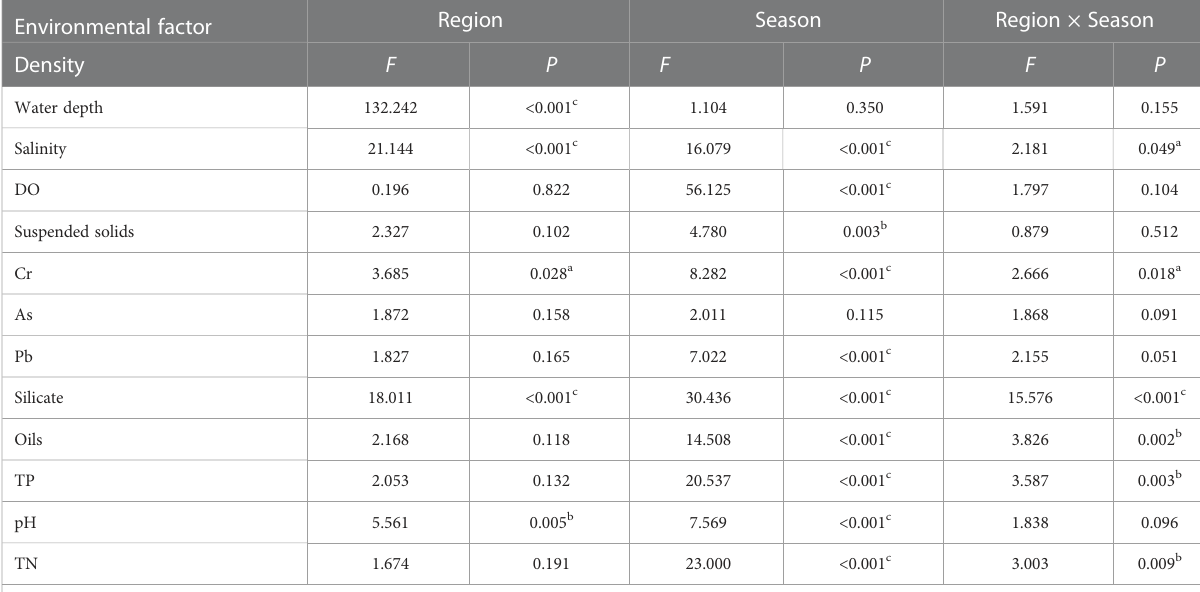
TABLE 3 The F and P values between seasons and regions for twelve environment factors in subtidal zone near the Daya Bay Nuclear Power Plant. Environmental factor